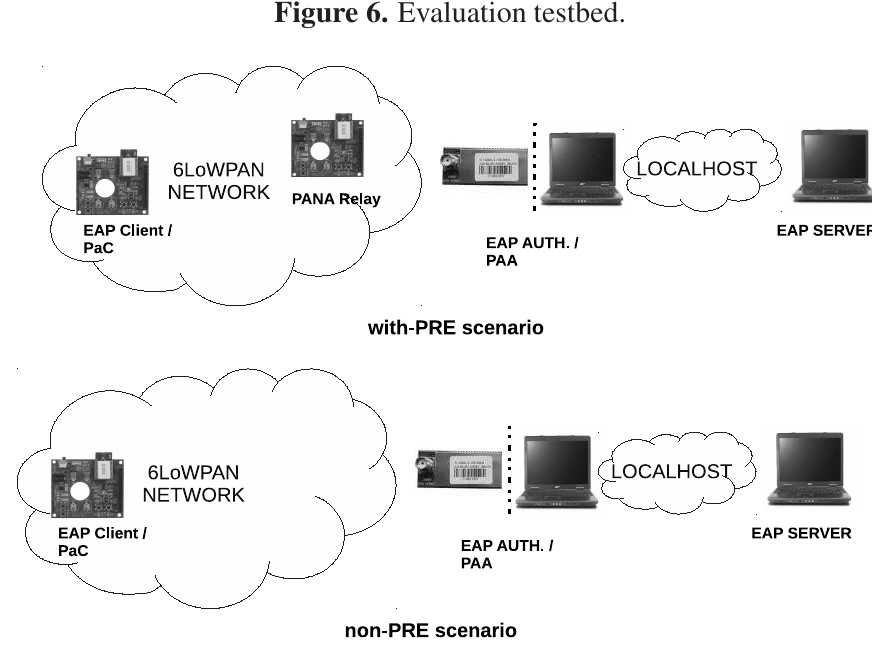
Figure 6. Evaluation